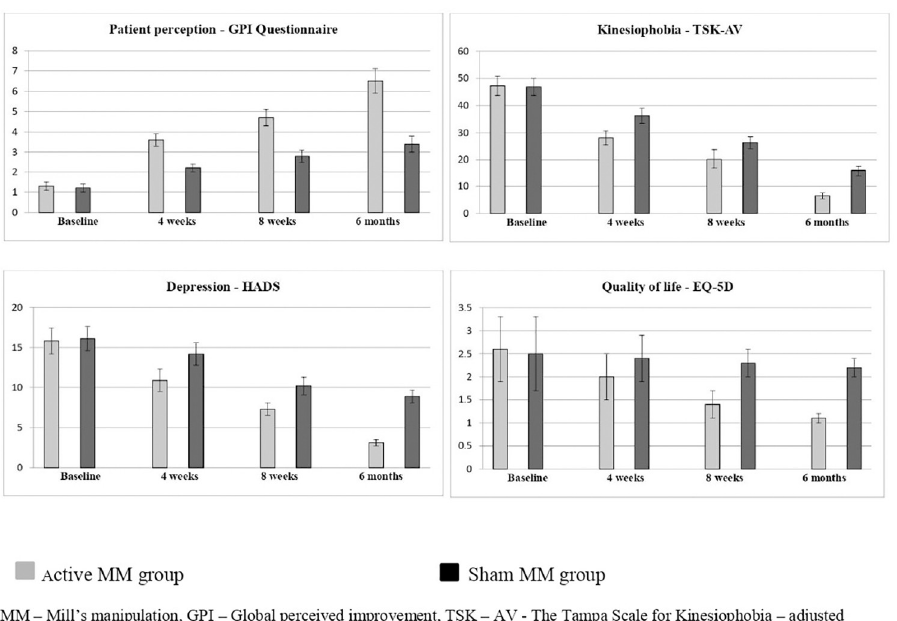
Fig 4. Pre and post-secondary outcome measures of active and sham ESWT